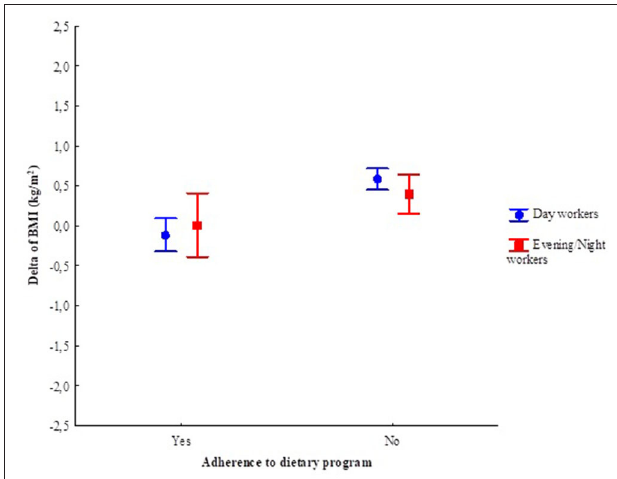
FIGURE 3 | Generalized linear model of the BMI delta (pre- and during the pandemic period), according to the work shift and adherence to dietary program. Adjusted by age and sex. Work shift: F (1, 142) = 0.06. p = 0.81; Adherence: F (1, 142) = 16.79. p < 0.01; Adherence *Work shift: